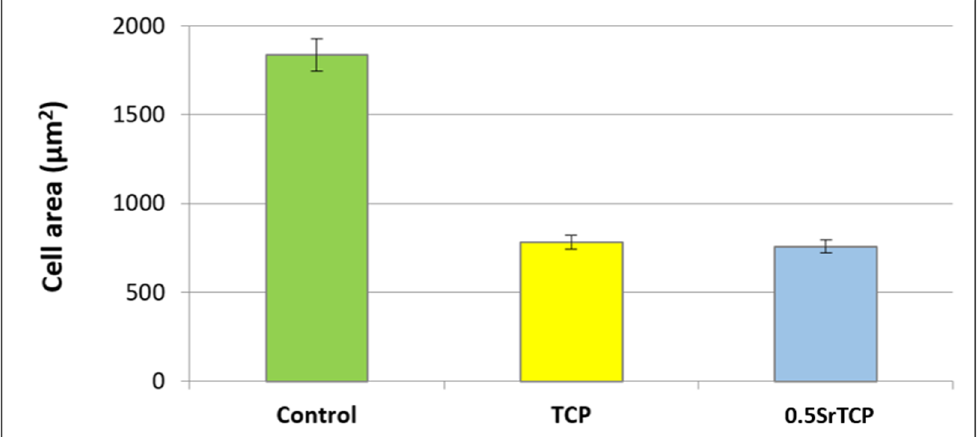
Figure 11. Spreading of MG ‐ 63 cells on control, TCP, and 0.5SrTCP ceramics (24 h of cell growth).